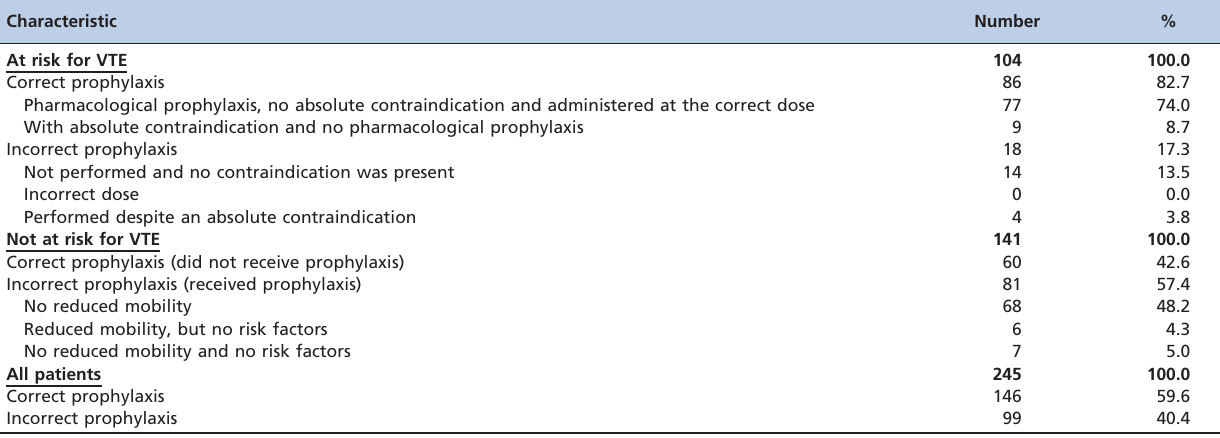
Table 3 - The adequacy of VTE prophylaxis according to the Brazilian Guidelines. Characteristic At risk for